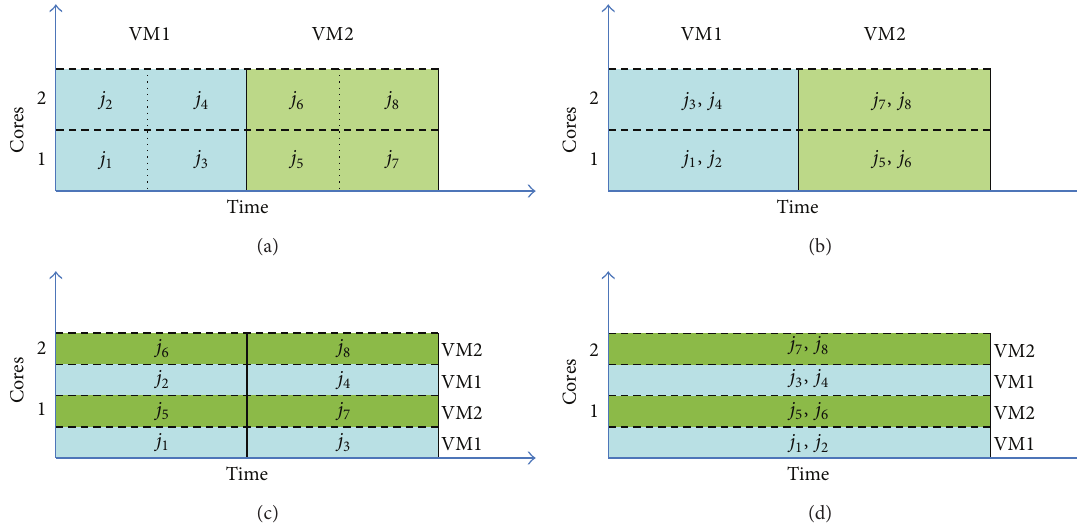
Figure 1: Time-shared and space-shared policy for VMs and jobs. (a) Space-share for VMs and jobs, (b) space-share for VMs and time-share for jobs, (c) time-share for VMs and space-share for jobs, and (d) time-share for VMs and jobs.